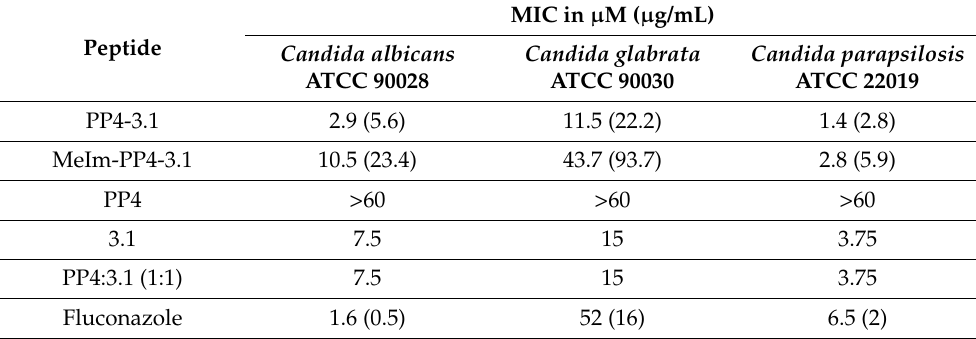
Table 5. Activity of the peptide constructs, respective parent peptides, and reference antifungal drug fluconazole, against ATCC Candida